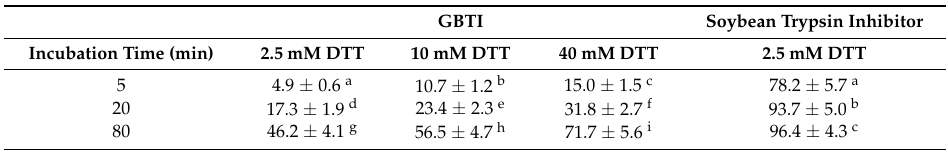
Table 3. Inhibition rate (%) of dithiothreitol (DTT) on the activity of GBTI and soybean trypsin inhibitor after incubation at 37 ◦ C for different durations.